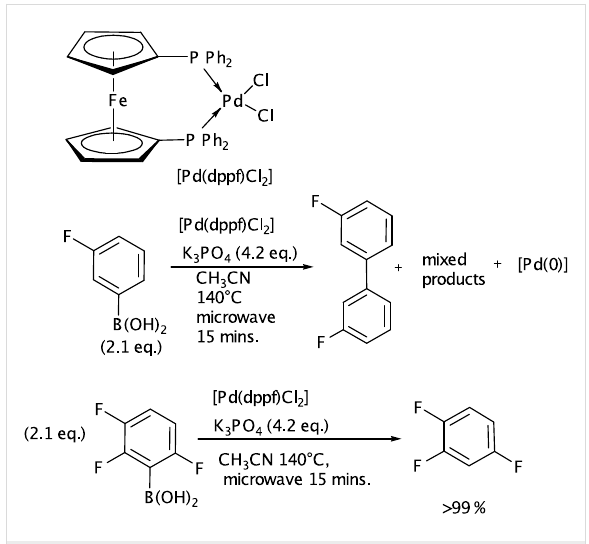
Scheme 4: Stoichiometric reactions between fluorinated boronic acids and [Pd(dppf)Cl 2 ].